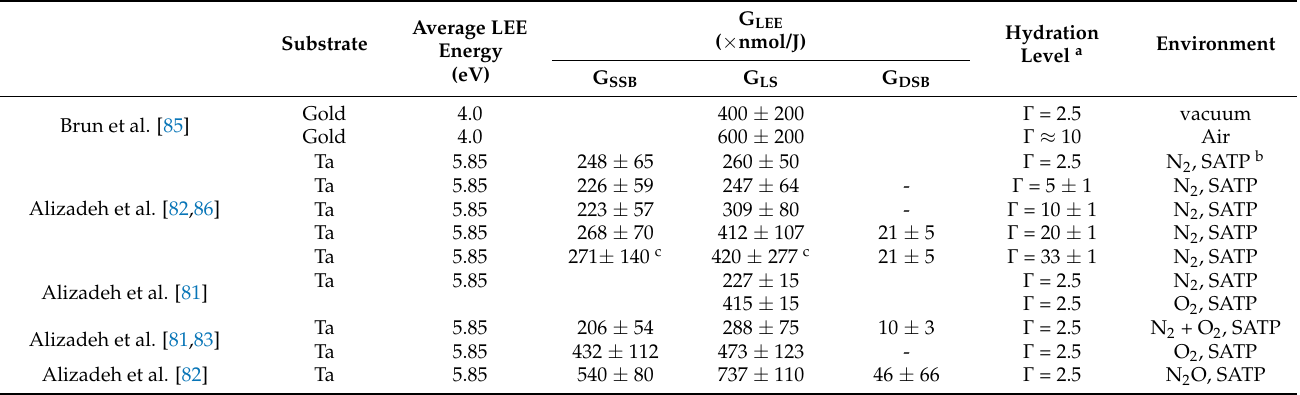
Table 2. Comparison of G-values for SSBs (G SSB ), DSBs (G DSB ) and loss of supercoil (total damage, G LS ) induced by 1.486 KeV X-ray photoelectrons emanating from a metal substrate covered with 5 MLs of plasmid